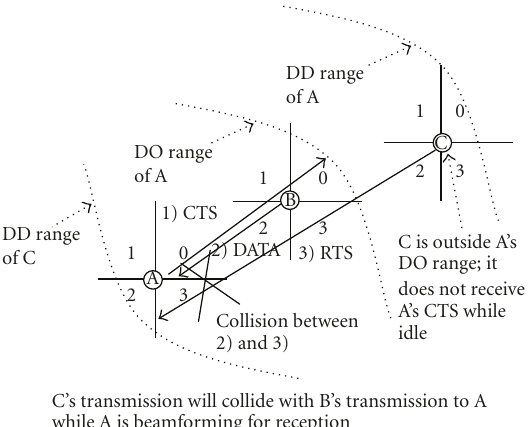
Figure 6: Illustration of the two types of deafness problems.